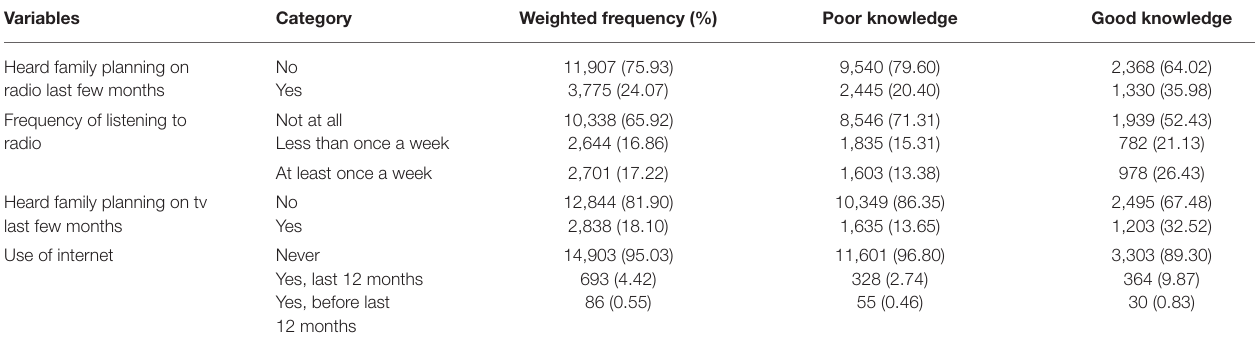
TABLE 2 | Modifying factors on knowledge about fertile period of respondents in Ethiopia, 2016 ( N = 15,683). Variables Category Weighted frequency (%) Poor knowledge Good knowledge Heard family planning on radio last few